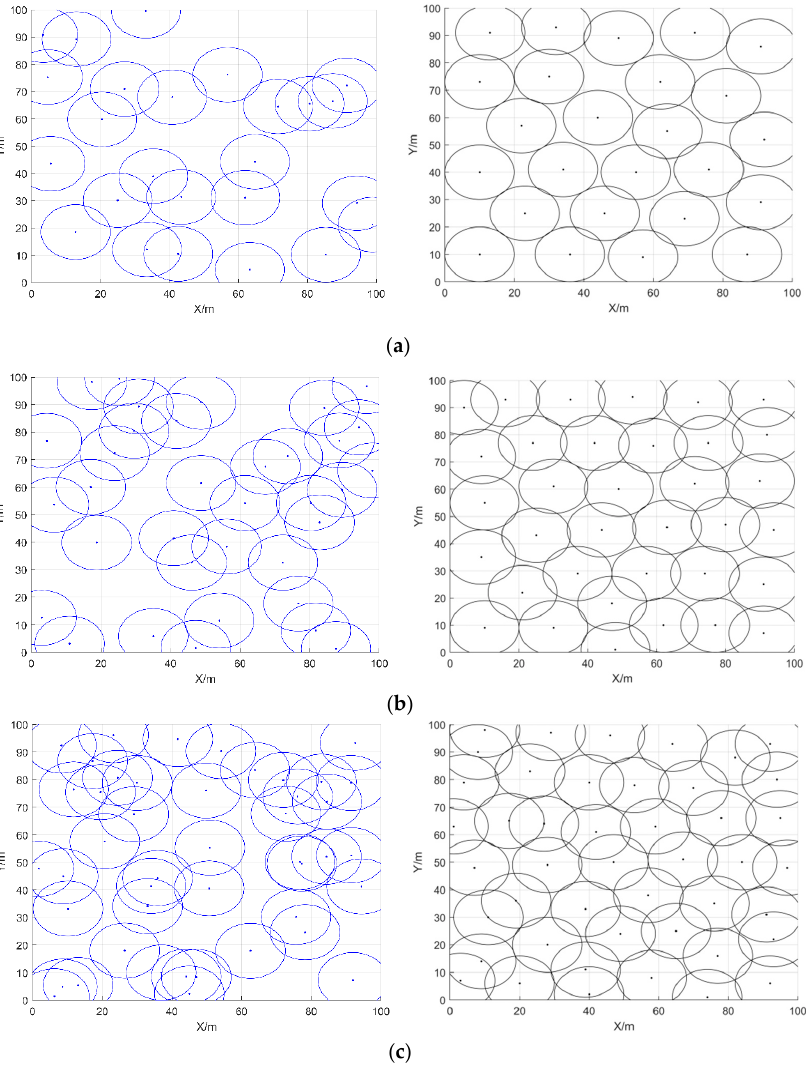
Figure 15. Initial coverage diagram and coverage optimization diagram of COOTCLCO in three cases: ( a ) q = 25, Rs = 10 m, Iteration = 1500; ( b ) q = 35, Rs = 10 m, Iteration = 1500; ( c ) q = 45, Rs = 10 m, Iteration = 1500.